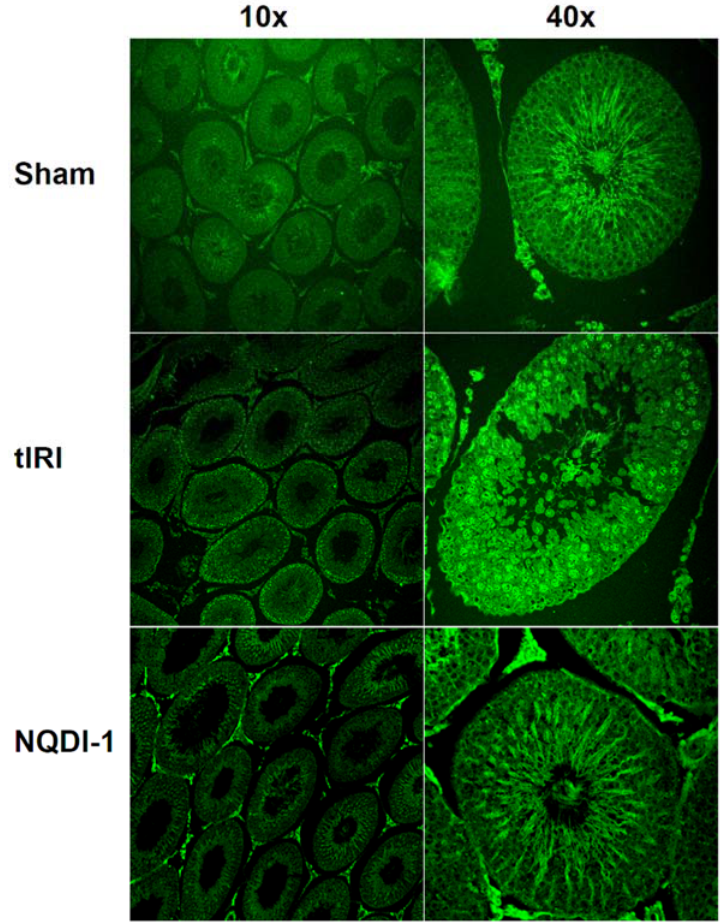
Figure 3. NQDI-1 prevents DNA strand breaks. Oxidative DNA strand breaks were assessed by counting TUNEL positive nuclei from 55 STs in testicular tissue sections / animal group. The STs of tIRI ‐ subjected testes showed an increased number of fluorescently labelled free DNA 3 ′ ends in comparison to sham and NQDI-1-treated rats ( p -value < 0.0001). Contralateral testes showed no significant difference between the three animal groups ( p ‐ value > 0.05). NQDI ‐ 1 (10 mg/kg) was i.p. injected 30 min post ischemia. Fluorescently stained tissue sections were visualized using the LSM700 confocal microscope. Images were taken at 10× and 40× magnification with a scale bar of 50 μ m.